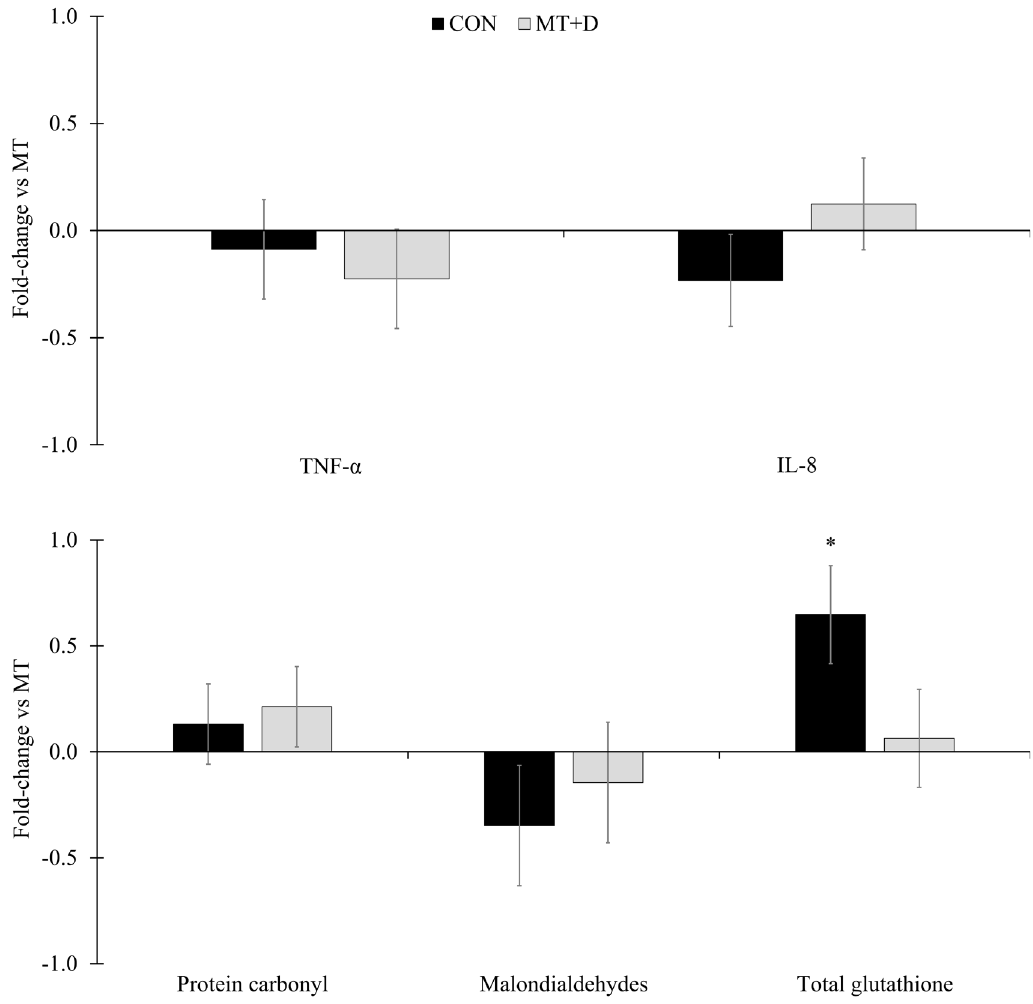
Figure 3. Inflammatory and oxidative stress markers in gut mucosa in weaned pigs consuming experimental diets with (MT) or without mycotox - ins (CON) for 5 weeks expressed as fold-change relative to pigs fed MT. CON, control diet formulated with minimal deoxynivalenol contamination; MT, CON + 1.9 mg/kg of deoxynivalenol supplemented from mycotoxin contaminated corn DDGS; MT+D, MT + mycotoxin-detoxifying additive (0.2% of MegaFix; ICC, São Paulo, Brazil); TNF-α, tumor necrosis factor-alpha; IL-8, interleukin-8. * 0.05≤p<0.10.